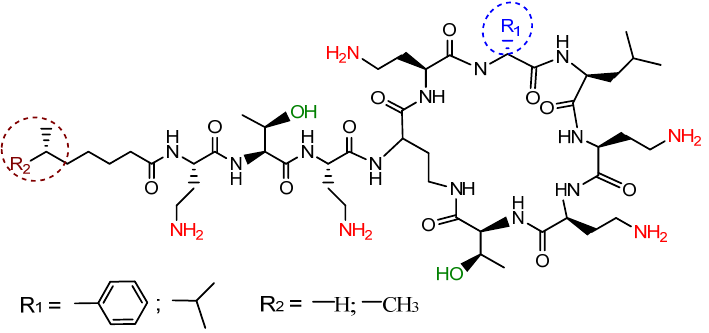
Figure 1. General structure of polymyxins.